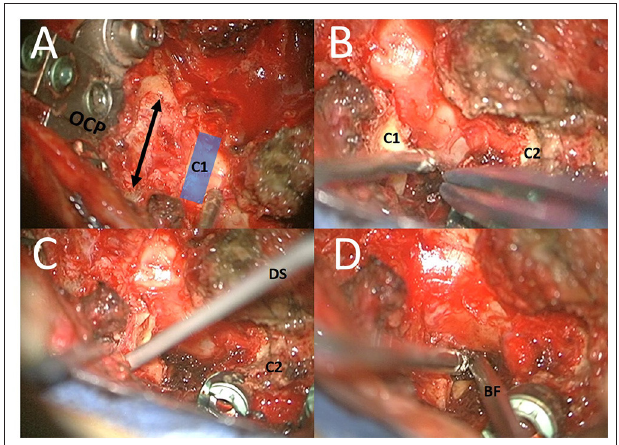
FIGURE 2 | Different steps of surgery: (A) In first step, fusion surgery of the CVJ C0–C4 was performed with an OC plate (OCP) with occiptocervical decompression (by enlargement of the foramen magnum and laminectomy of the medial C1 arc); (B,C) After fusion and decompression the lower lateral part of the C1 arc (subperiostal, with remnant upper C1 arc) and the lateral superior part of the left side of the C2 arc. Doppler sonography (DS) was used to analyze the anatomy of vertebral artery. (D) The entry point was located directly above the superior part of the C2 root. The trajectory was located medial to the pedicle of C2, medial to the C1–C2 facet joint, and medial to the tubercle for the transverse ligament of the atlas. A biopsy of the lateral portions of the lesions was obtained by bioptic forceps (BF) under microscope